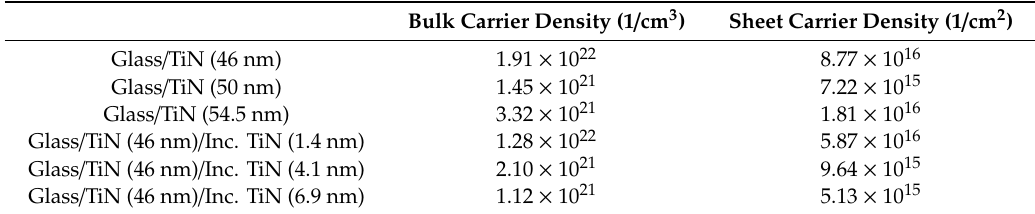
Table 1. Charge carrier concentrations of samples with various deposited thicknesses of the TiN thin layer. The error of the measurement is smaller than 1%.